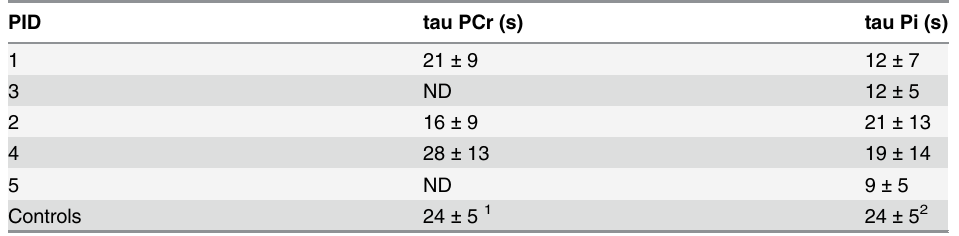
Table 4. PCr and Pi recovery